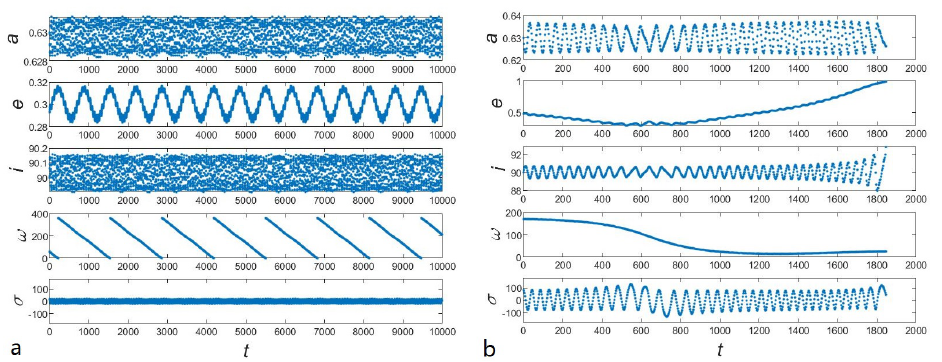
Figure 2. Dynamical evolution of the representatives of the surviving (plane ( a )) and dead (plane ( b )) particles. From top to bottom panel: semi-major axis a , eccentricity e , inclination i , argument of pericenter ω , 2/1 critical angle σ , respectively.